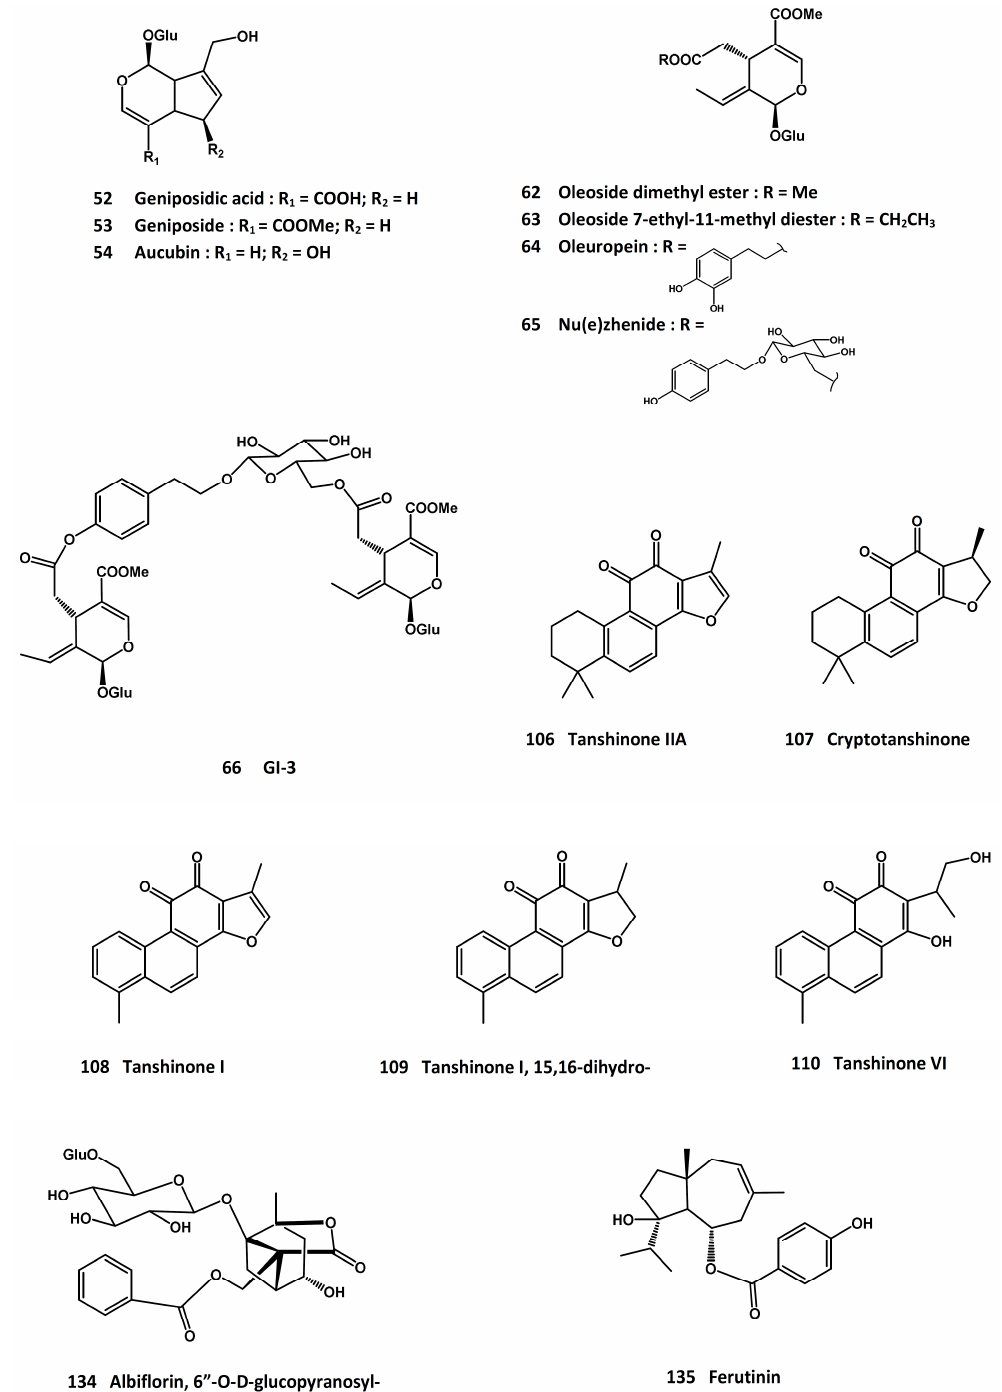
Figure 7. Monoterpenoids, Sesquiterpenoids and Diterpenoids Reported to Possess Osteoprotective Property. In an attempt to explore the potential utilization of other plant parts of E. ulmoides , an ethanol extract of the leaves were found to promote the growth of MC3T3-E1 cells and suppress the H2O2-indcued apoptosis [240]. It also prevented ovariectomy-induced osteoporosis and obesity in rats [241]. On the other hand, the total glycosides obtained from the seeds of E. ulmoides increased bone mineral density, bone volume/tissue volume ratio, connectivity density, trabecular number, and trabecular thickness in normal rats